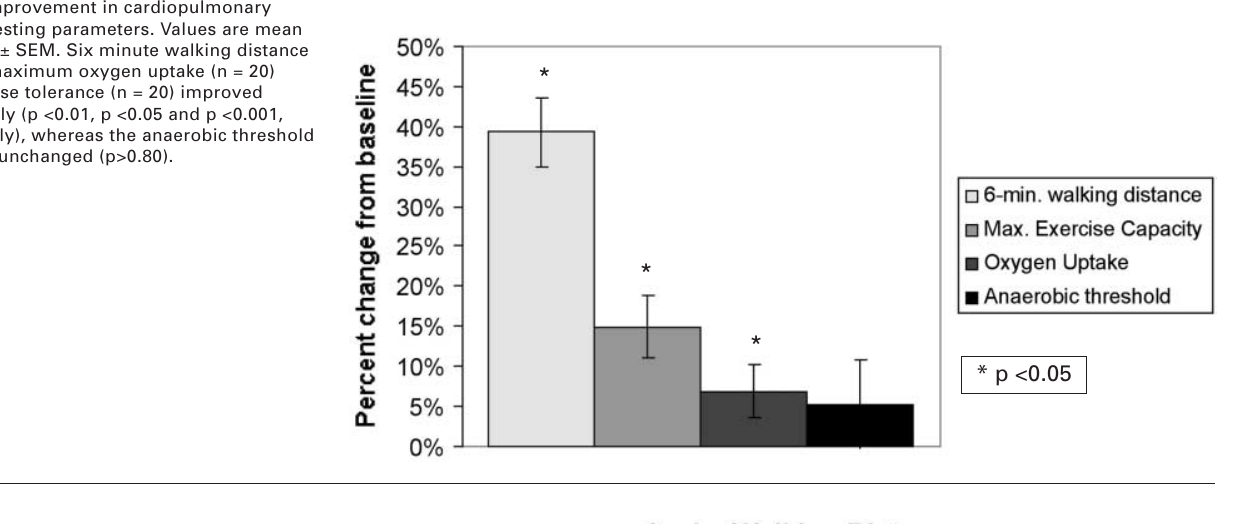
Walking distance at study entry (n = 10), at completion of the rehabilitation programme (n = 10) and after 12 months (n = 8). Two patients were lost to follow-up due to death (n = 1) and serious illness (n =